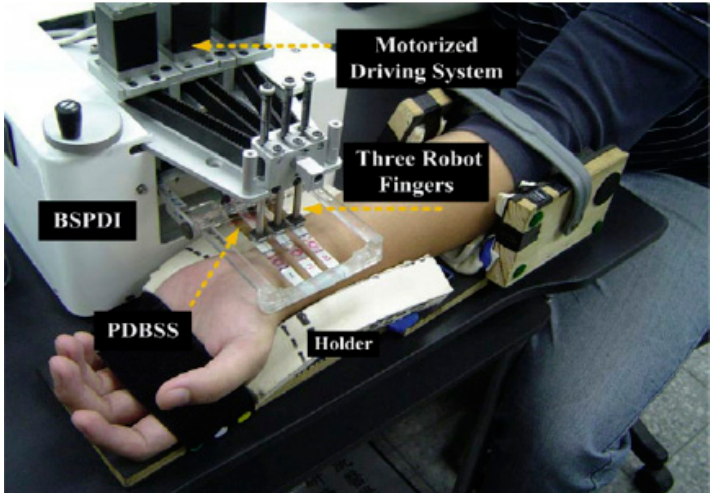
Figure 4. Bi-Sensing Pulse Diagnosis Instrument (BSPDI) equipped with a Pressure-Displacement Bi-Sensing System (PDBSS). Reprinted with permission from ref. [77]. Copyright 2012 Elsevier and Copyright Clearance